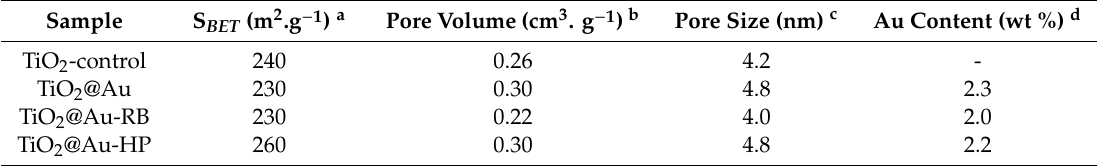
Table 1. Surface properties and gold loading of the different TiO 2 materials.